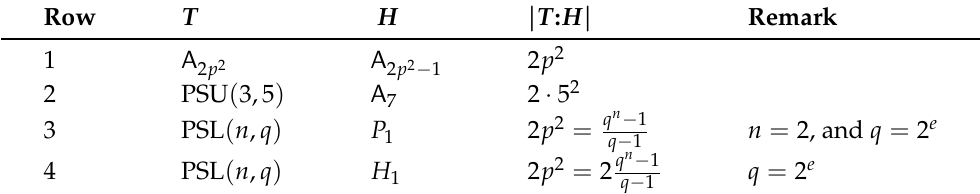
Table 1. Non-abelian simple group containing subgroups with index 2 p 2